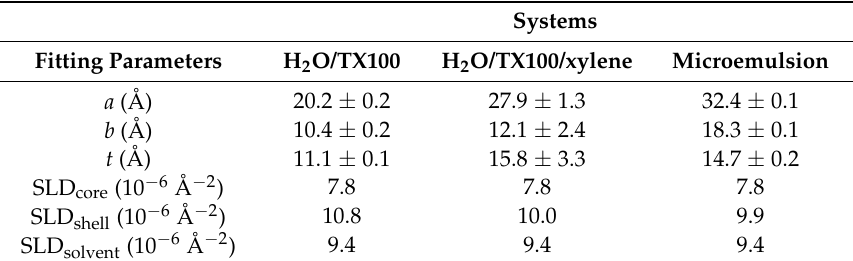
Table 2. SAXS fitting parameters for the three systems